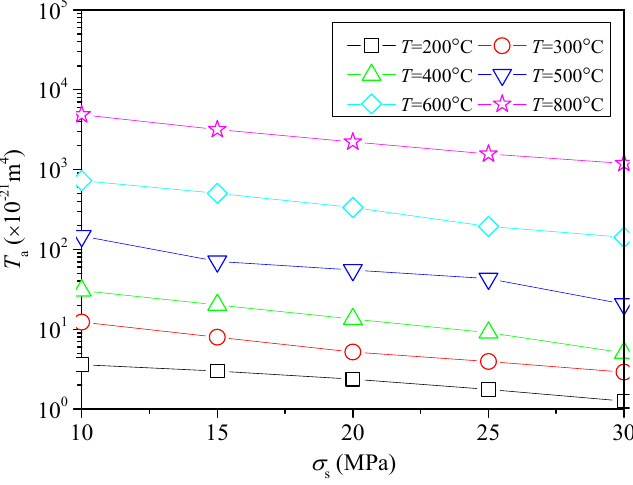
Figure 10. Transmissivity as a function of the confining pressure.